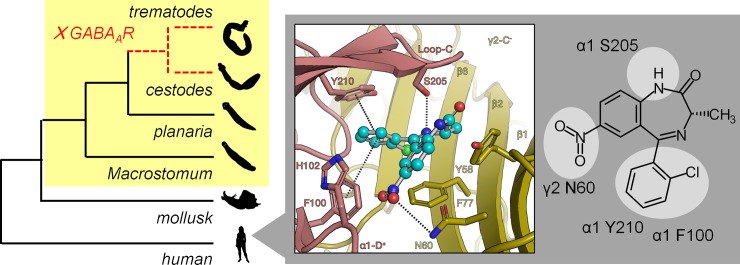
MCLZ interaction with host GABAARs.Within the flatworm phylum (highlighted yellow), GABAARs are present in free living Macrostomum and planarians, but are lost in parasitic flatworms (dashed line). Inset—While the flatworm target has still to be identified, in silico docking of MCLZ to the benzodiazepine binding site of the solved human heteromeric α1β3γ2 GABAAR cryo-EM structure [29] reveals predicted interactions with amino acid side chains on the α1 and γ2 subunits (dashed lines). Right - 2D chemical structure of MCLZ, with potential GABAAR interactions highlighted.